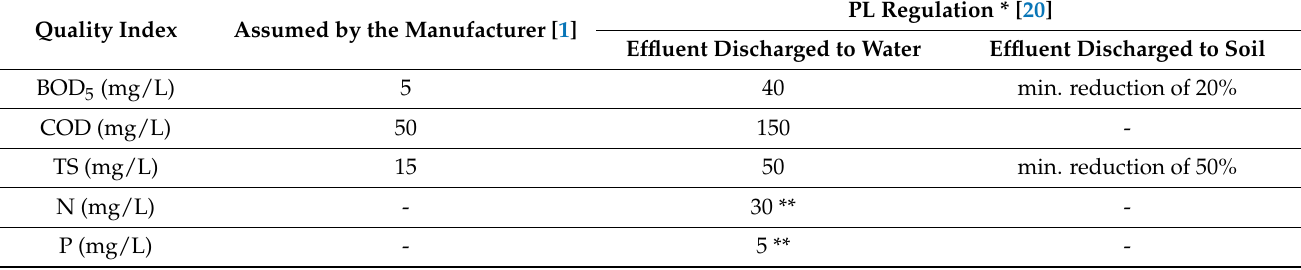
Table 3. Assumed and required effluent quality parameters.